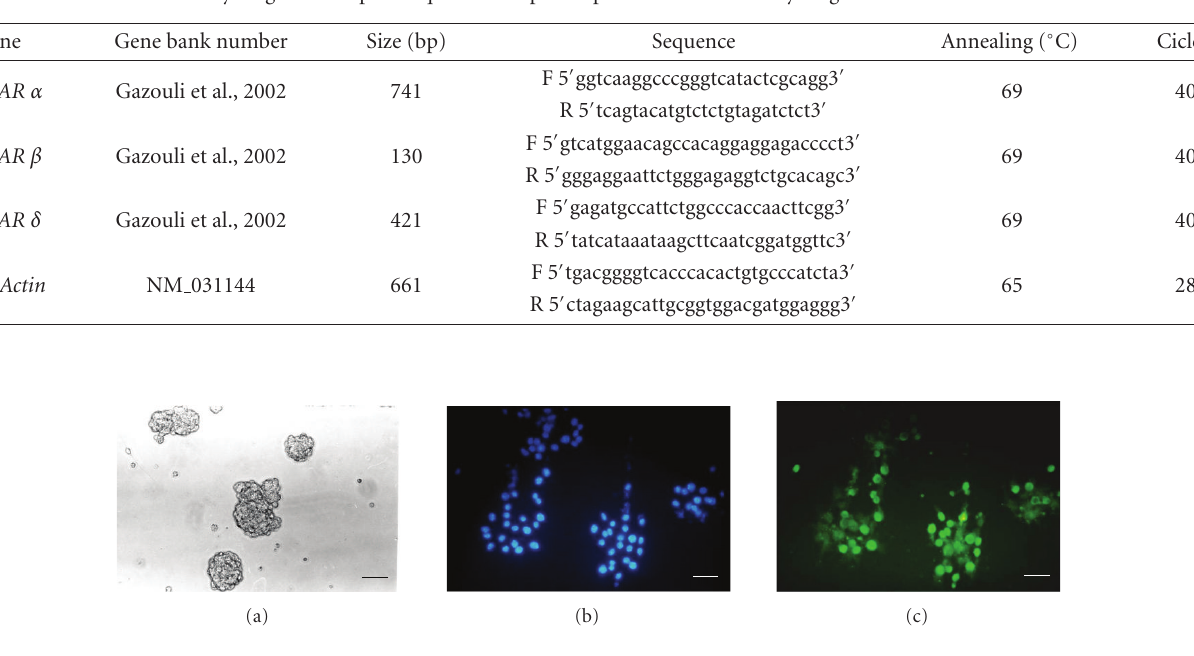
Table 1: Primers and PCR cycling. The adopted sequences of specific primers and relative cycling conditions of each RT-PCR are indicated.